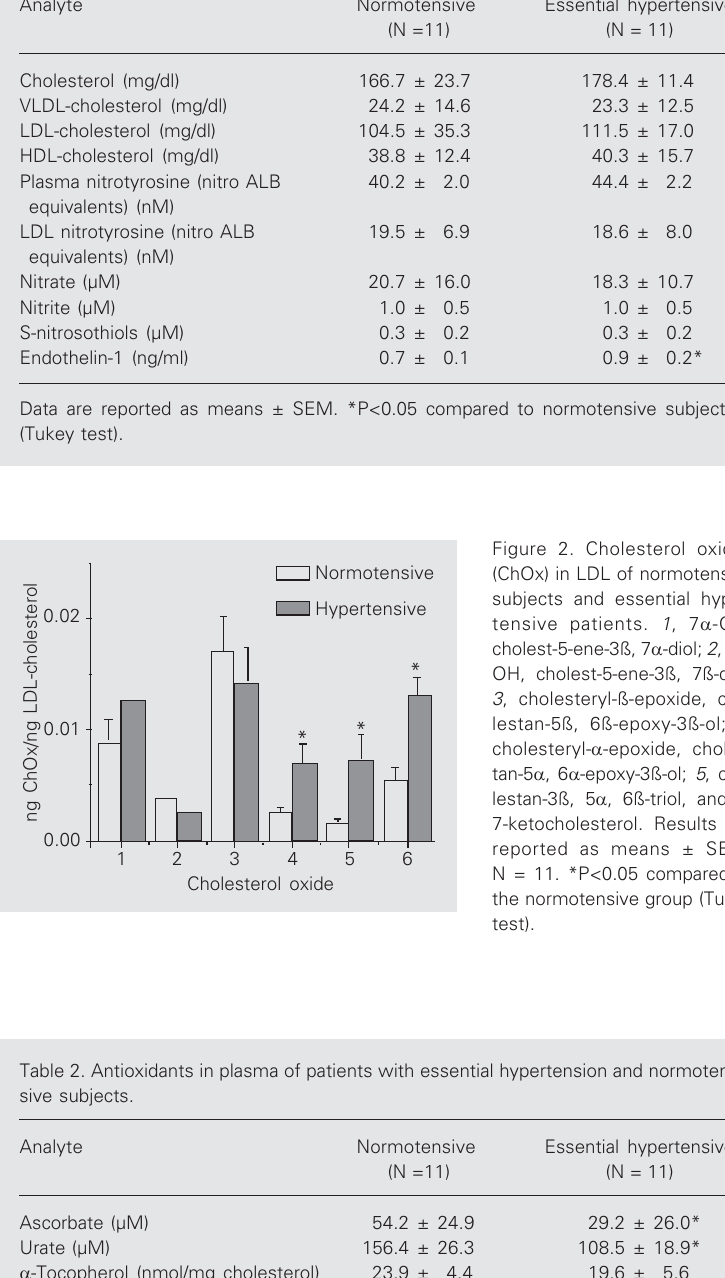
Table 1. Lipids, endothelin-1, nitrotyrosine and nitric oxide derivatives in plasma of patients with essential hypertension and normotensive subjects. Analyte